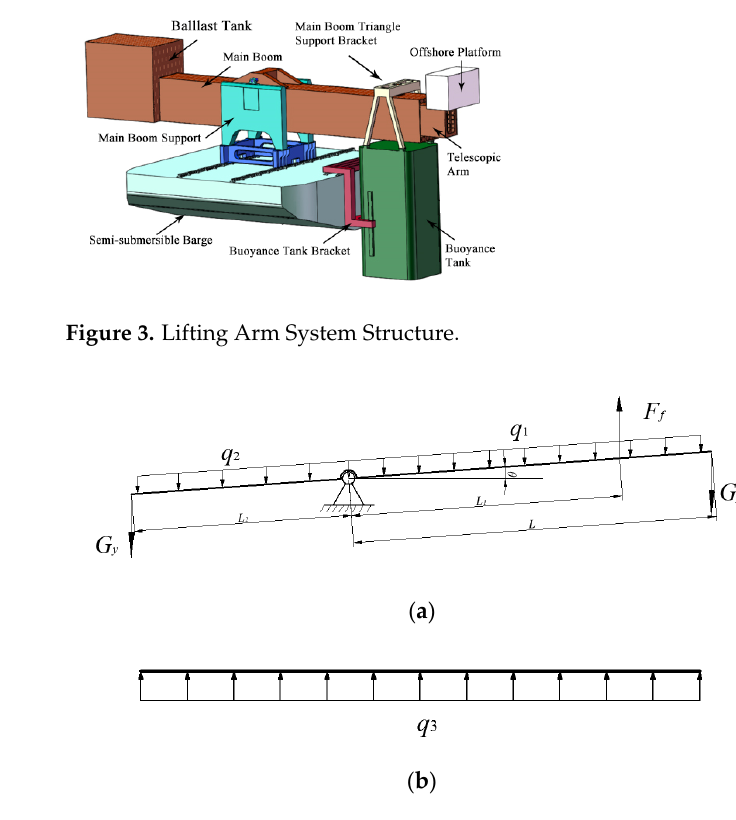
Figure 4. Force Diagram of the Lifting Arm in the Vertical ( a ) and Horizontal Directions ( b ) with the Assumption of Self ‐ weight Distributed Uniformly. Table 1. Parameters of the Dynamic Model.